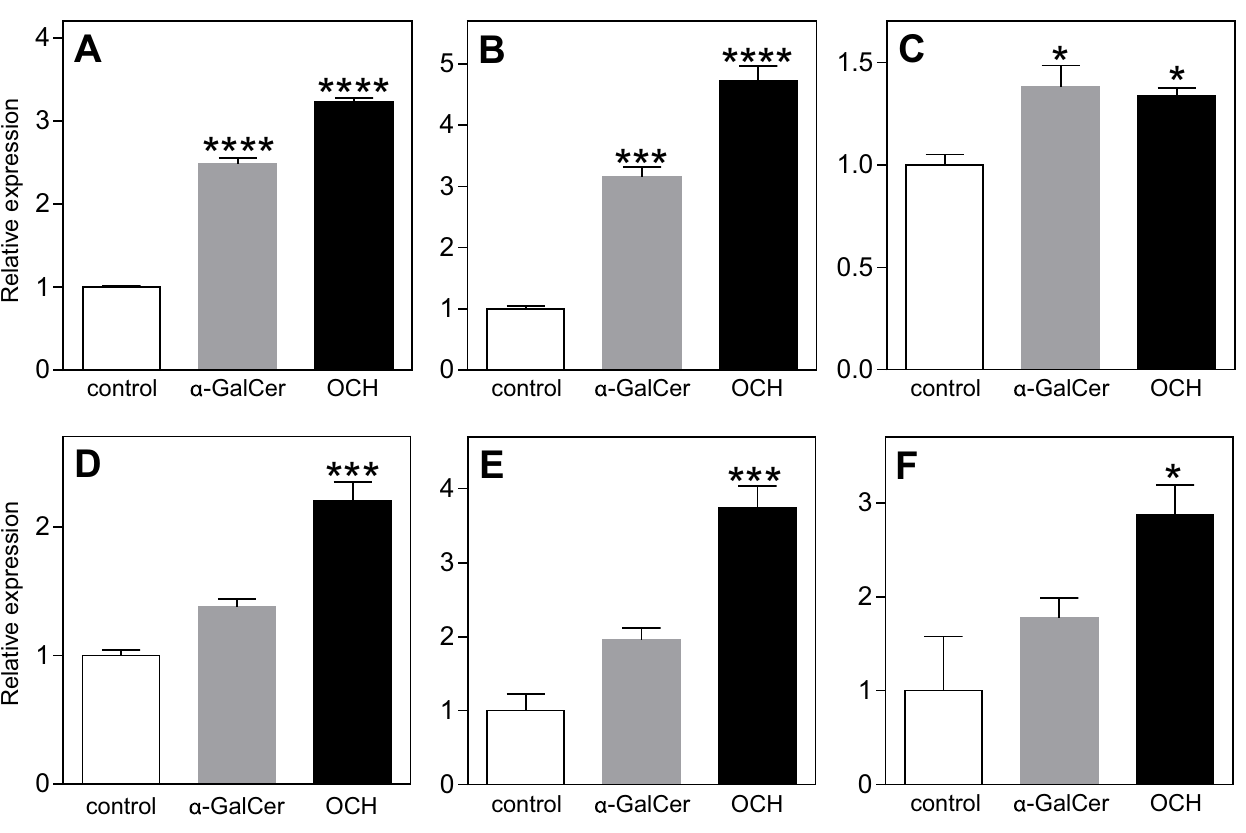
Fig 4. Increased expression of matrix degrading molecules by vSMCs and macrophages after type I NKT cell activation. Splenocytes of LDLr -/- mice were incubated with or without type I NKT cell specific ligands α -GalCer and OCH for 48 hours. Subsequently, supernatant of the splenocytes was added to vSMCs (A-C) or macrophages (D-F) for 72 hours after which the mRNA expression of the matrix degrading molecules Cathepsin S (A and D), MMP-12 (B and E), Cathepsin K (C) and Cathepsin L (F) was determined. All values are mean ± SEMand statistical analysis was performed using one-way ANOVA. (cid:3) P < 0.05, (cid:3)(cid:3)(cid:3) P < 0.001, (cid:3)(cid:3)(cid:3)(cid:3) P < 0.0001.